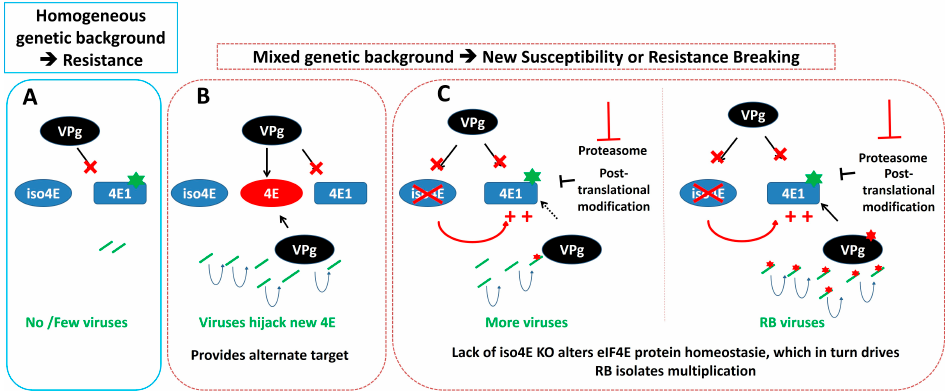
Figure 3. Potential effects of the genetic background on a eIF4E-based resistance to a viral pathogen. ( A ) Simple representation of eIF4E-based resistance. ( B ) Potential modulation of this resistance (or resistance breaking) in mixed genetic background through the presence of an additional eIF4E factor (indicated in red), or ( C ), by regulation of eIF4E accumulation level through feedback mechanisms or modulation of the eIF4E level regulation. Increased eIF4E accumulation allows minimal virus replication and results in the emergence of RB isolates. Mutations affecting the host eIF4E1 or the viral VPg are represented by green and red stars, respectively. The ‘plus’ sign indicates an increased accumulation of eIF4E1. The ‘cross mark’ indicates that the virus cannot recruit the corresponding eIF4E